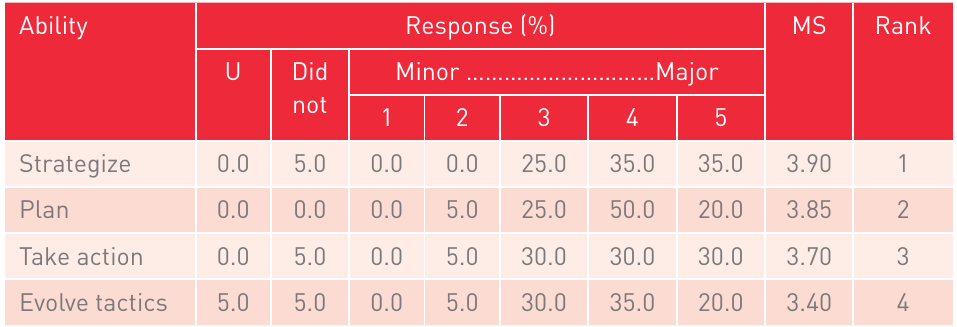
Extent to which the team building activities enhanced participants’ various